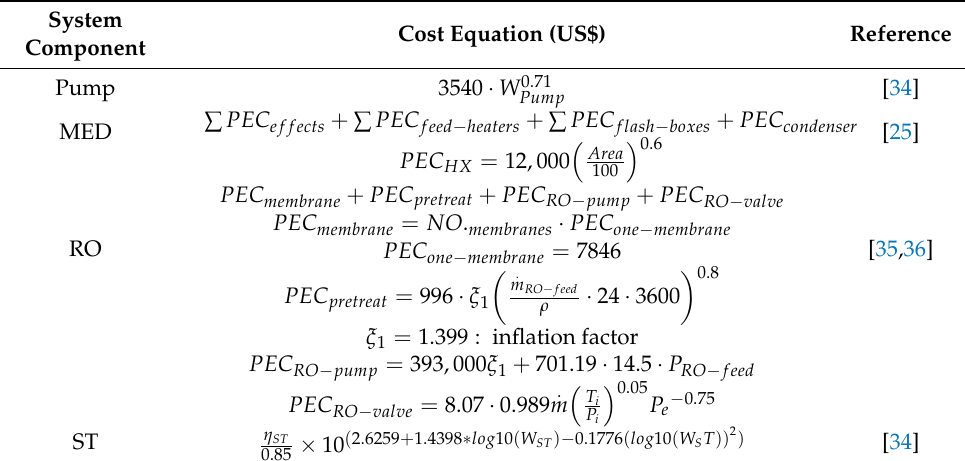
Table A3. Cont. System